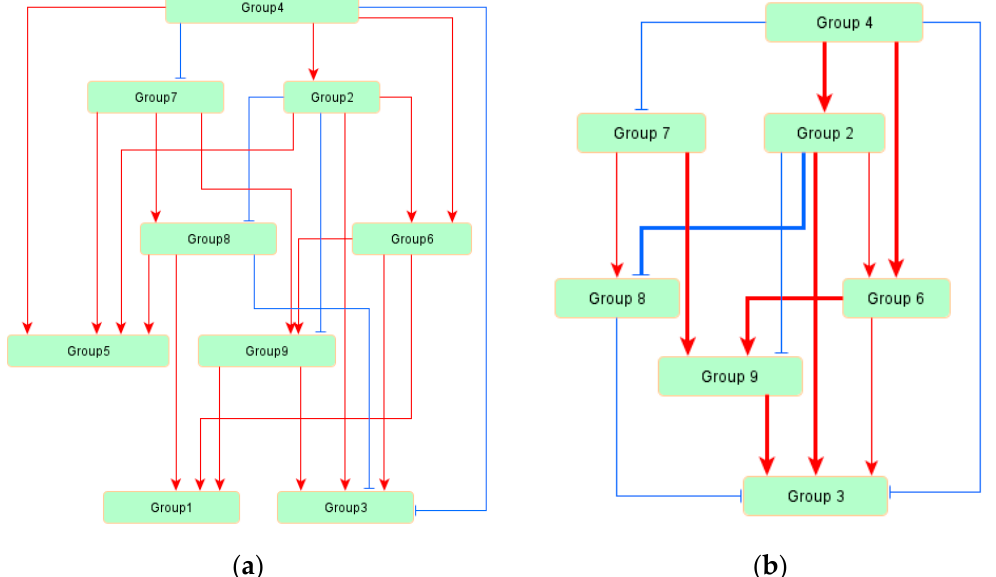
Figure 2. The regulatory network model for triacylglyceride (TAG) biosynthesis. Each group includes some genes as components. Red arrows indicate positive regulations, and blue arrows indicate negative regulations: ( a ) the inferred whole network model; and ( b ) the extracted regulatory network model for Group 3. Group 3 included “oil productivity” as a component, and the regulation in Group 3 means the regulation in TAG biosynthesis. Bold lines indicate strong regulations ( > 0.3), and thin lines indicate weak regulations ( < 0.3). Table 5. Estimated regulations and regression weights of the TAG biosynthesis regulatory model. Table 4. Goodness-of-fit scores for the TAG biosynthesis regulatory model. CMIN ( P ) GFI AGFI CFI RMSEA